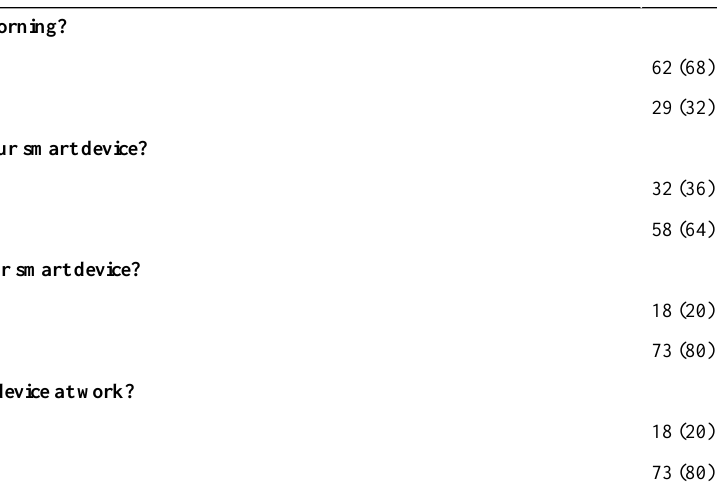
Table 10. Smart device use addiction score details. test CAGE tool